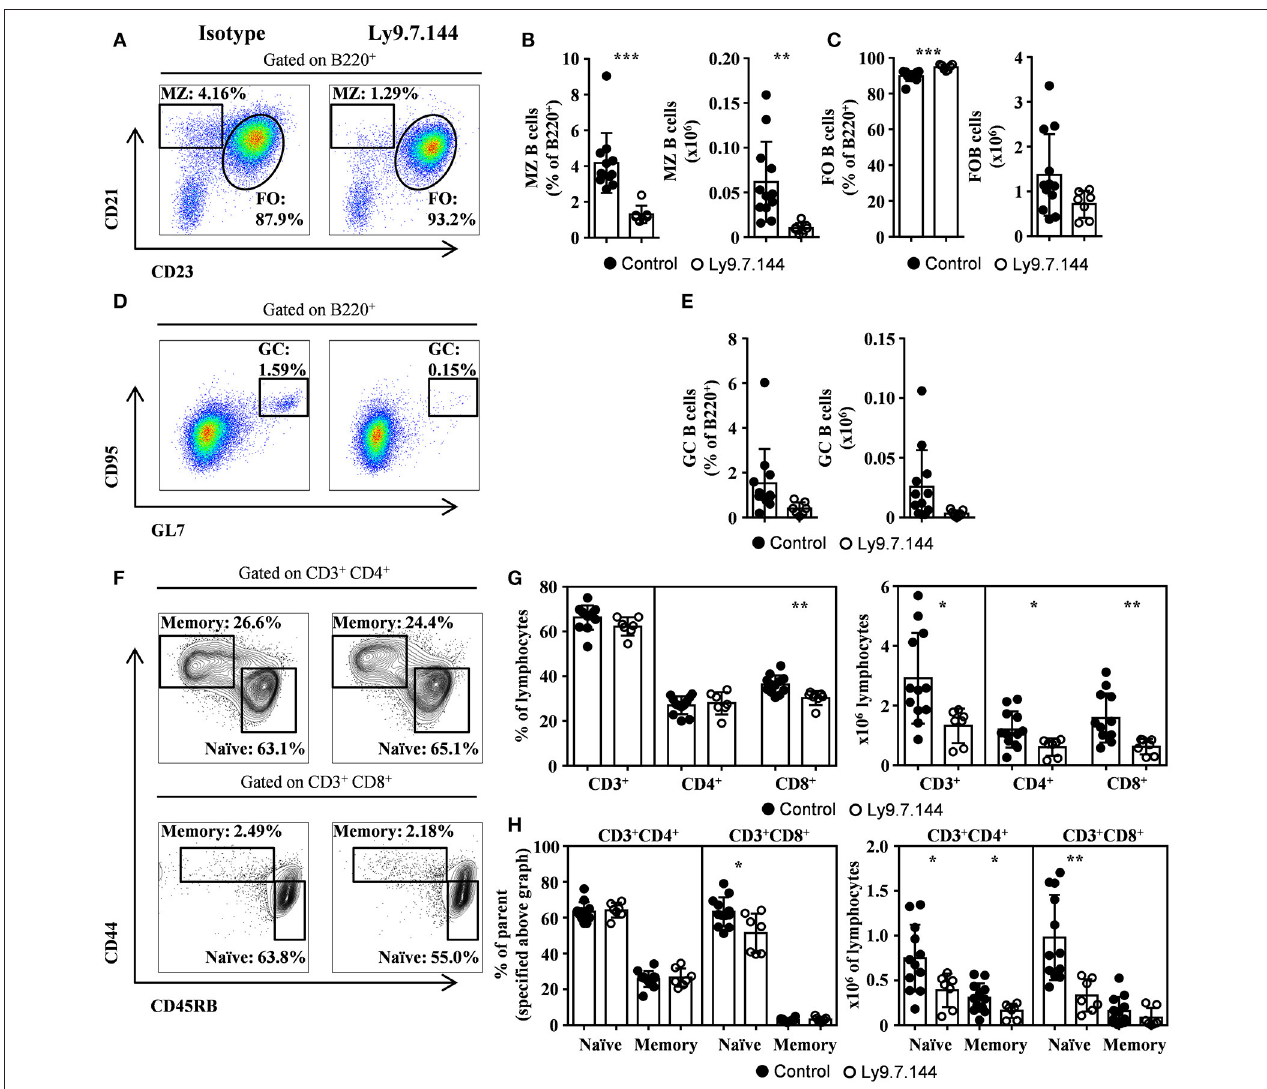
FIGURE 2 | MZ and GC B cells, and naïve T cells are diminished by Ly9.7.144 injection in the draining lymph nodes of SjS mice. Representative dot plots are shown for draining lymph nodes MZ and follicular B cells (A), GC B cells (D) and CD4 + or CD8 + memory and naïve T cells (F) from female NOD.H-2 h4 treated with Ly9.7.144 (right plots) or isotype control (left plots). Percentage and absolute counts for the different cell subsets are shown: MZ B cells (B) ; follicular B cells (C) ; GC B cells (E) ; CD3 + , CD4 + , and CD8 + cells (G) and CD4 + or CD8 + naïve and memory T cells ( H ; percentages are from parental CD3 + CD4 + or CD3 + CD8 + as specified). Mice treated with Ly9.7.144 mAb are represented as empty dots and mice treated with isotype control are represented as black dots. Results are expressed as mean ± SD. * p < 0.05; ** p < 0.01; *** p < 0.001 (unpaired two-tailed t-test). Data are pooled from three independent experiments.